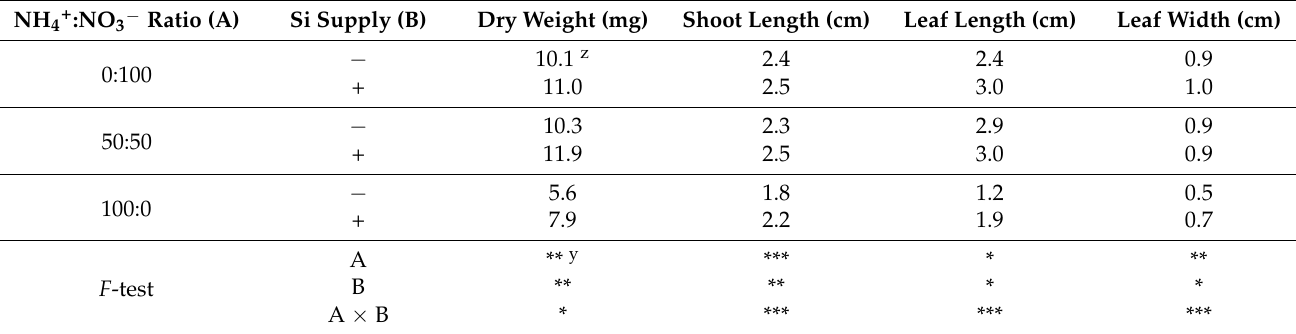
Table 2. Responses of the dry weight, shoot length, and leaf length and width to the three NH 4+ :NO 3 − ratios and Si application.